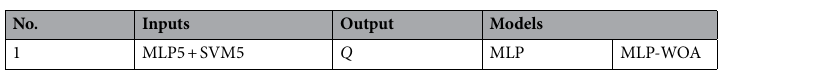
No. Inputs Output Models 1 MLP5 + SVM5 Q MLP MLP-WOA Table 10. Intended scenarios for the implementation of MLP and MLP-WOA models.